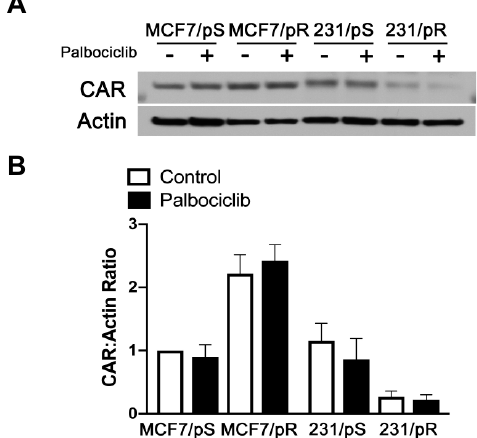
Figure 4. Coxsackie-adenovirus receptor (CAR) expression correlates with sensitivity to OAdmCherry. ( A ) Cells were treated with either the vehicle (H 2 O) or palbociclib (500 nM), harvested after 24 h and immunoblotted with the indicated antibodies. ( B ) Quantitative densitometry analysis is shown as the ratio of CAR to actin protein normalized to MCF7 / pS vehicle-treated cells ± SEM from three independent experiments.